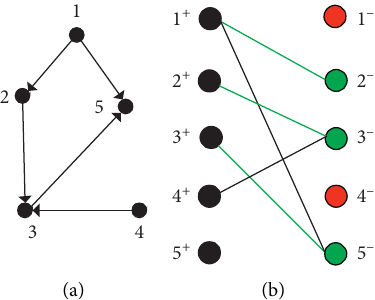
Figure 1: A simple network, its bipartite representation, and its maximum matching. (a) A simple network with five nodes and five edges. (b) The bipartite representation of the network and its maximum matching. Matched (unmatched) nodes are shown in green (red) and matching edges are shown in green,